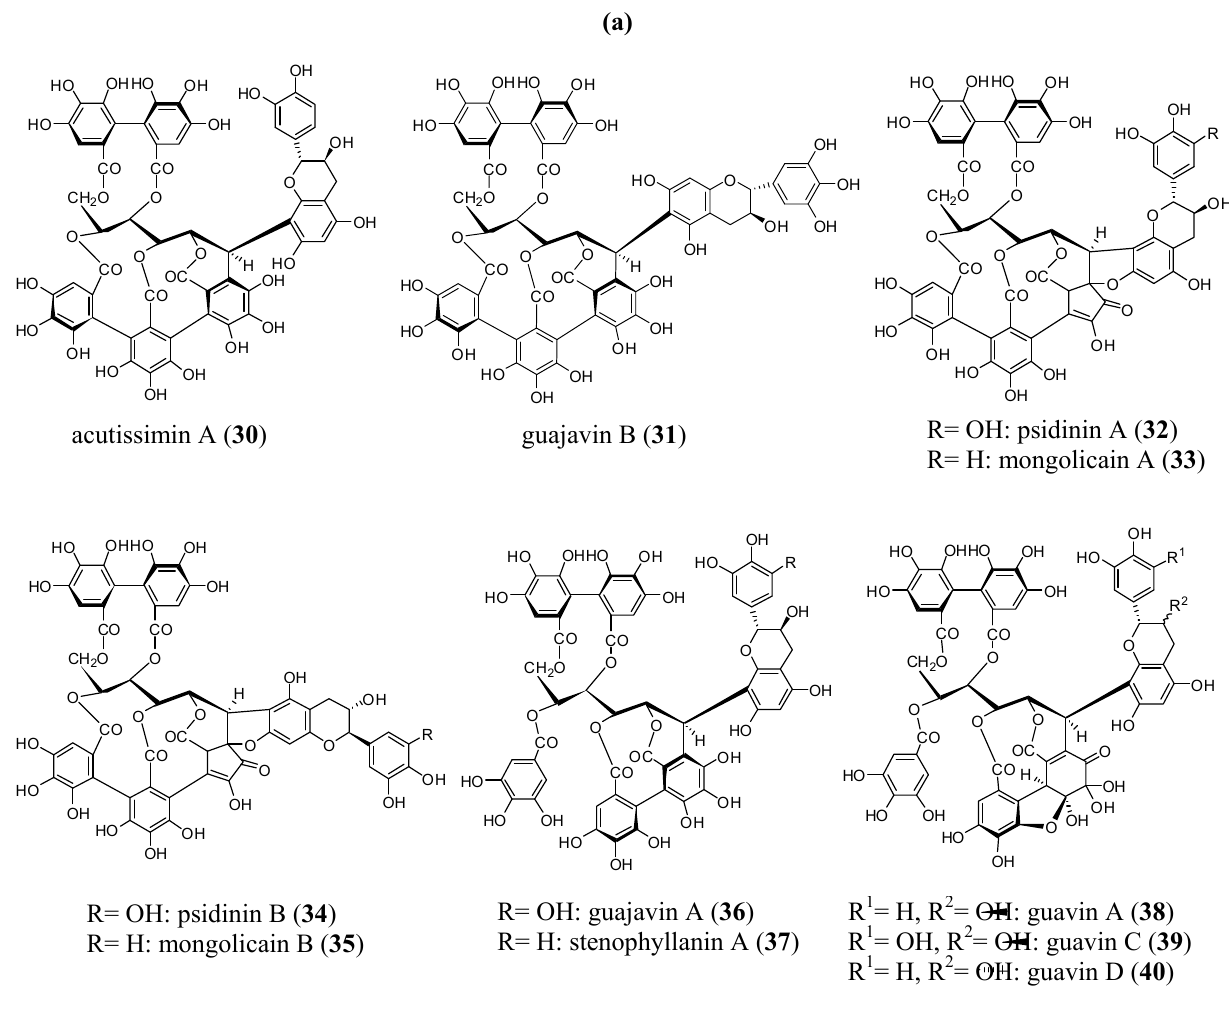
Figure 3. (a) Structures of complex tannins 30 – 40 . (b) Structures of complex tannins 41 – 44